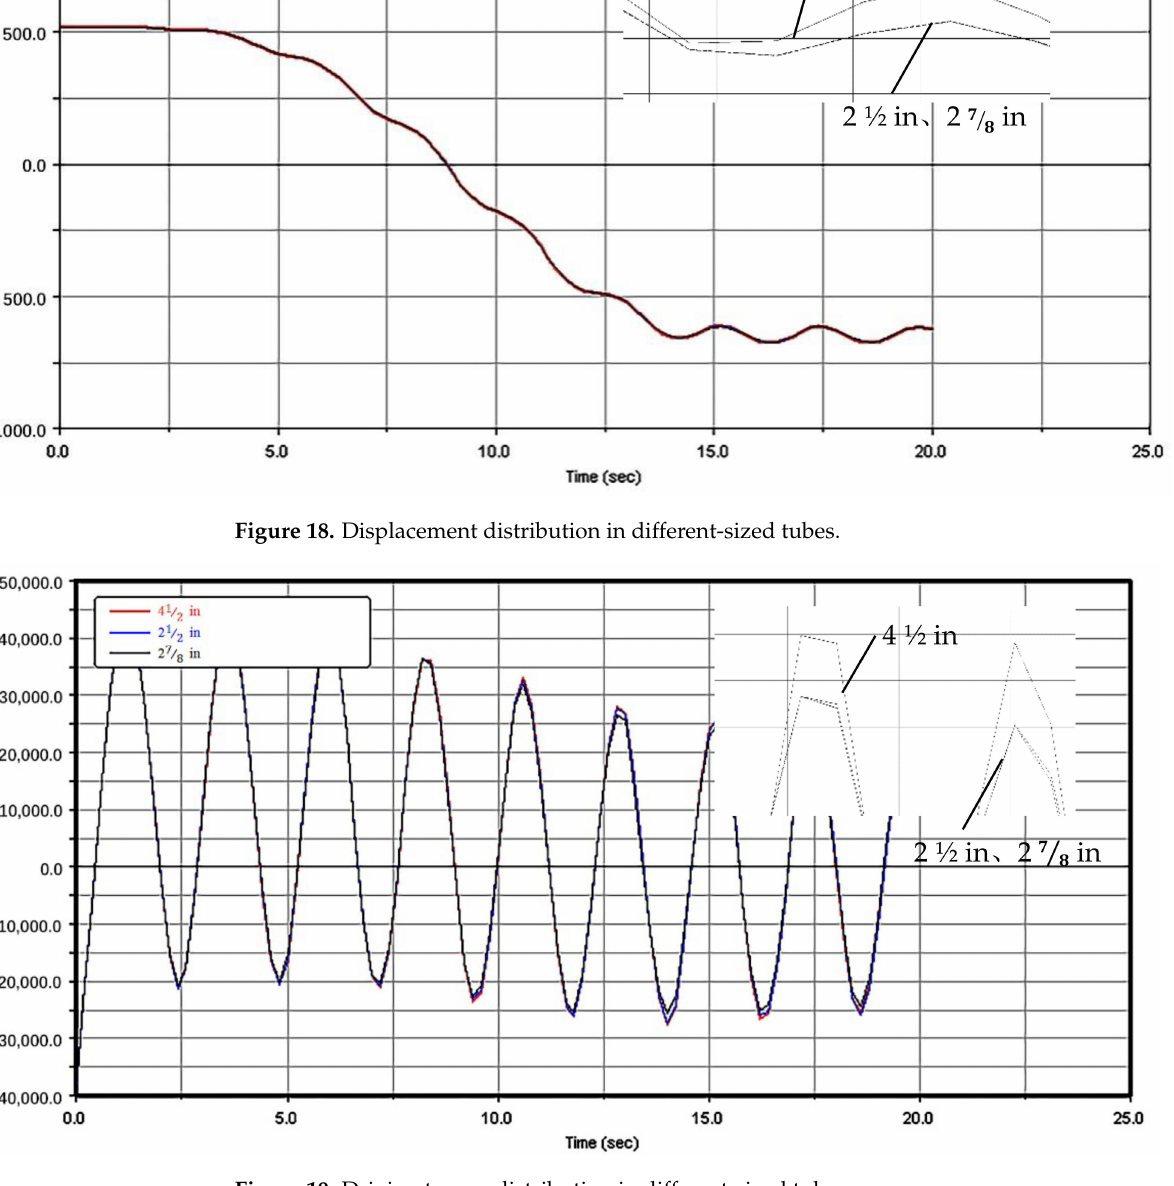
Figure 19. Driving torque distribution in different-sized